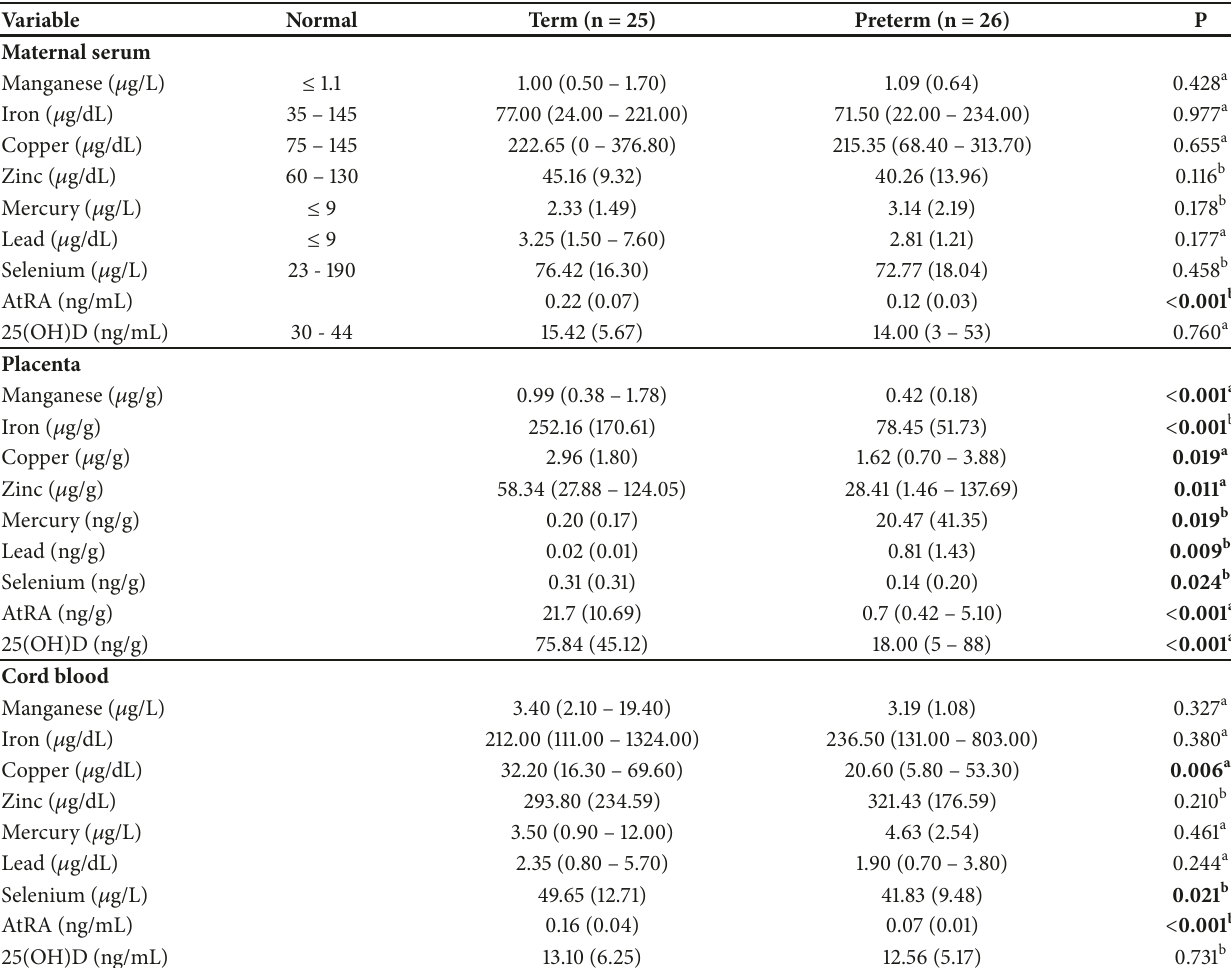
Table 3: Trace elements concentration of maternal serum, placenta, and cord blood. Placental concentration of all trace elements shows higher antioxidant concentration and lower concentration of mercury and lead, while only AtRA shows significant difference in maternal serum, as well as copper, selenium, and AtRA in cord